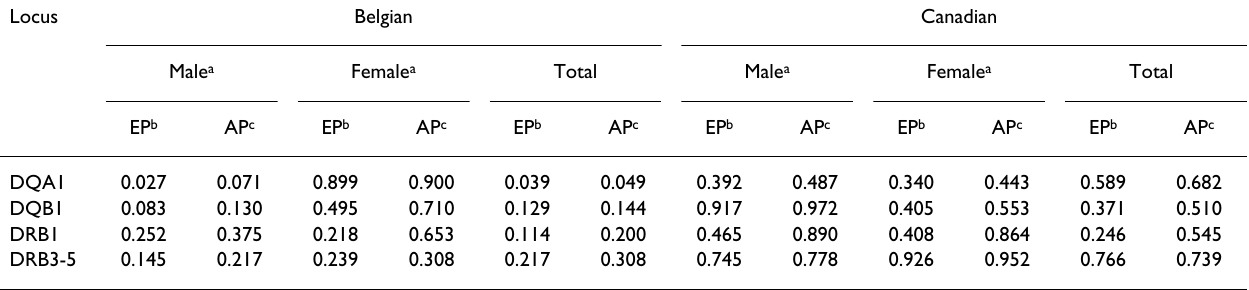
Table 5: Empirical and asymptotic p-values for comparisons between AAA cases and controls within each population and stratified by sex